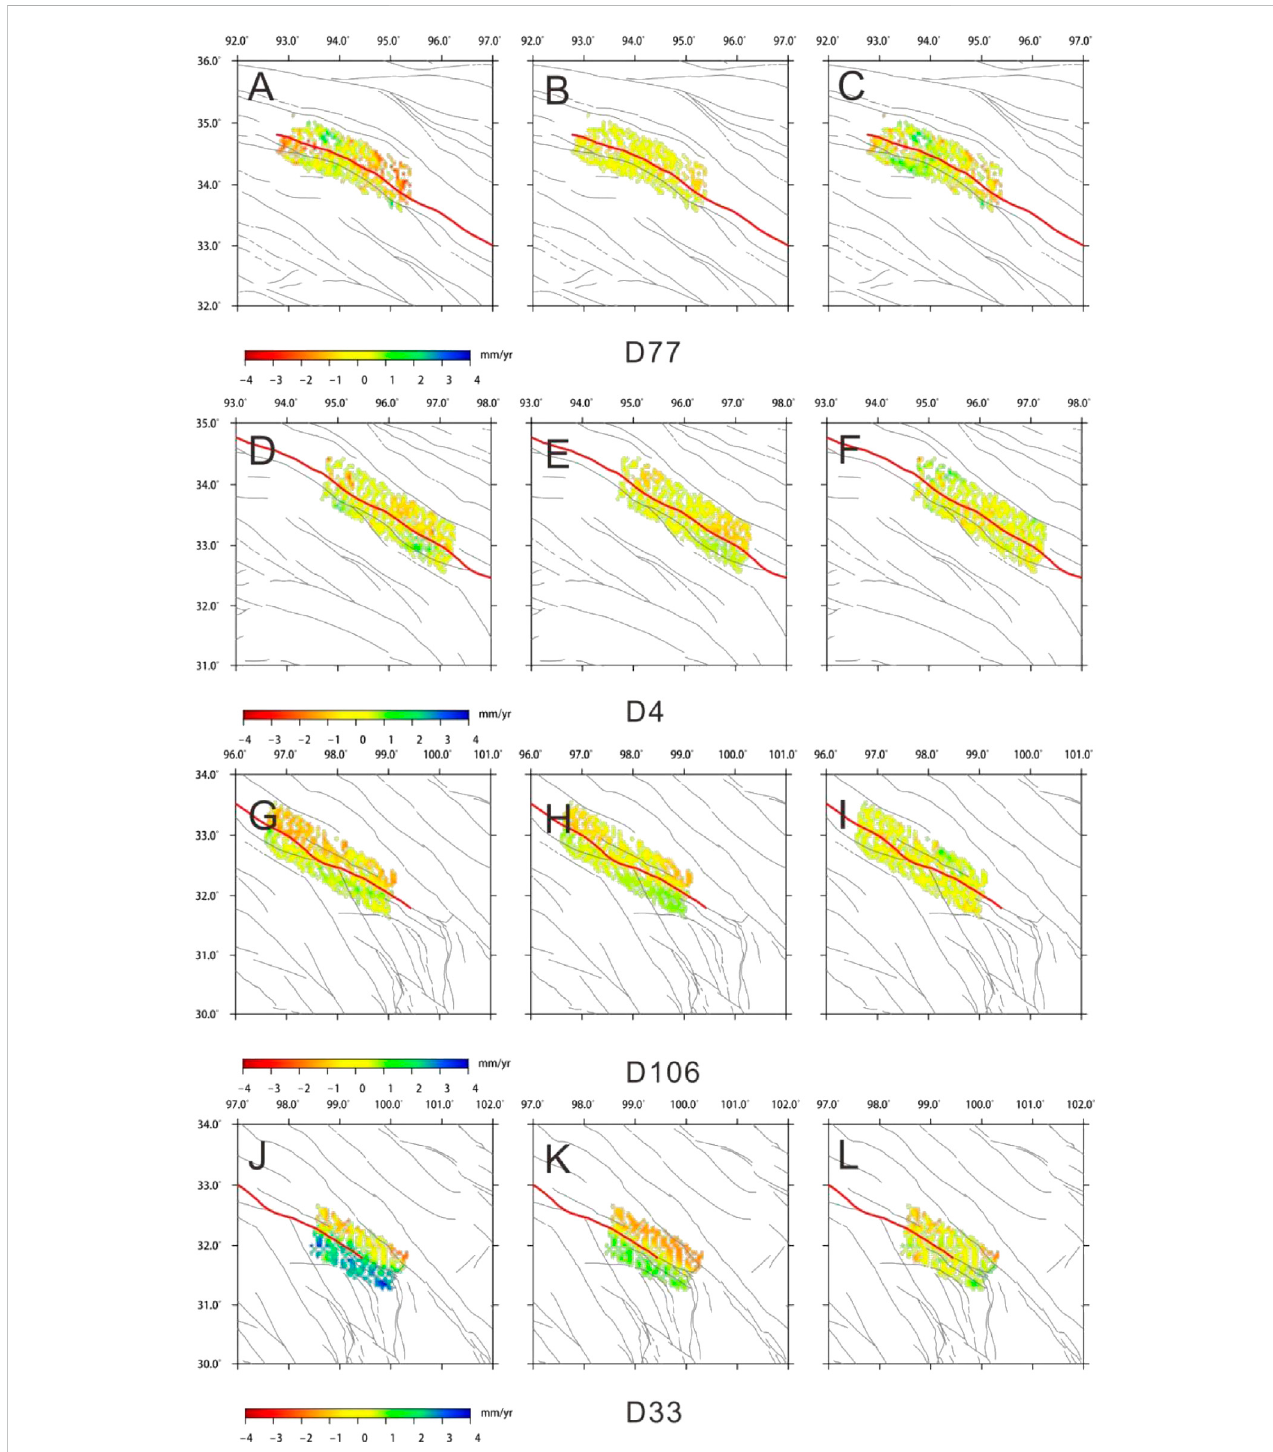
south ground motion in the entire segment. Thus, the eastward motion of crustal material escaping from the Tibetan Plateau has decreased, and the fault-parallel slip rate here is clearly lower than that on either side (Li et al., 2016; Wu et al., 2017).